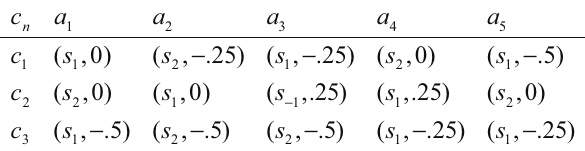
G after second aggregation. Table 1 2. The final decision matrix after third Table 11. Decision matrix of 2